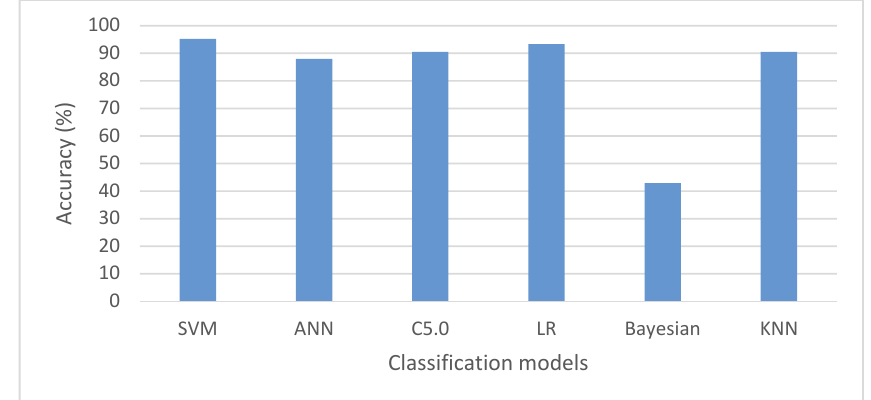
Fig. 9. Accuracy results of the classification models in situation 1